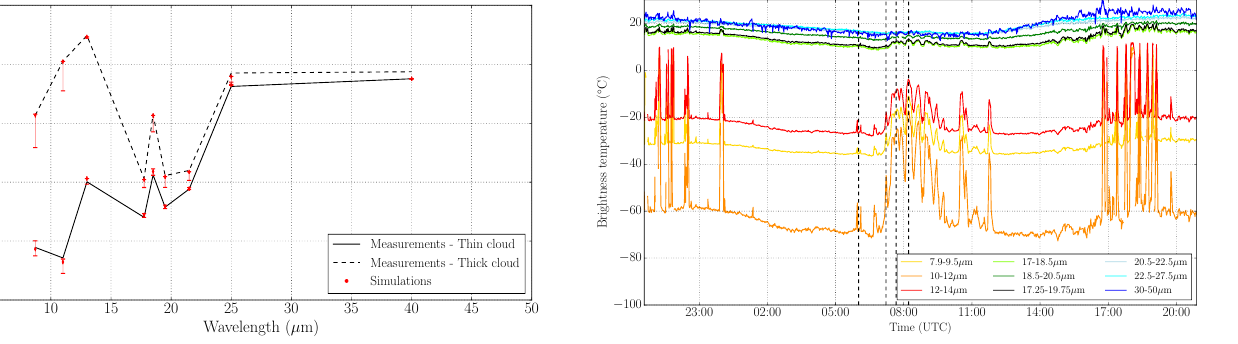
Figure 14. Radiances measured with the FIRR and simulated with MODTRAN for the 21 February 2015 experiment. Two cases are shown with different cloud covers. The thin cloud simulation corre- sponds to a cloud between 2.3 and 3.8km with τ = 0 . 3 and d eff = 20µm (16:09UTC) and the thick cloud simulation corresponds to a cloud between 2.3 and 3.8km with τ = 12 . 5 and d eff = 40µm (18:21UTC). Error bars indicate the range of radiances obtained for d eff varying from 3 to 250µm.